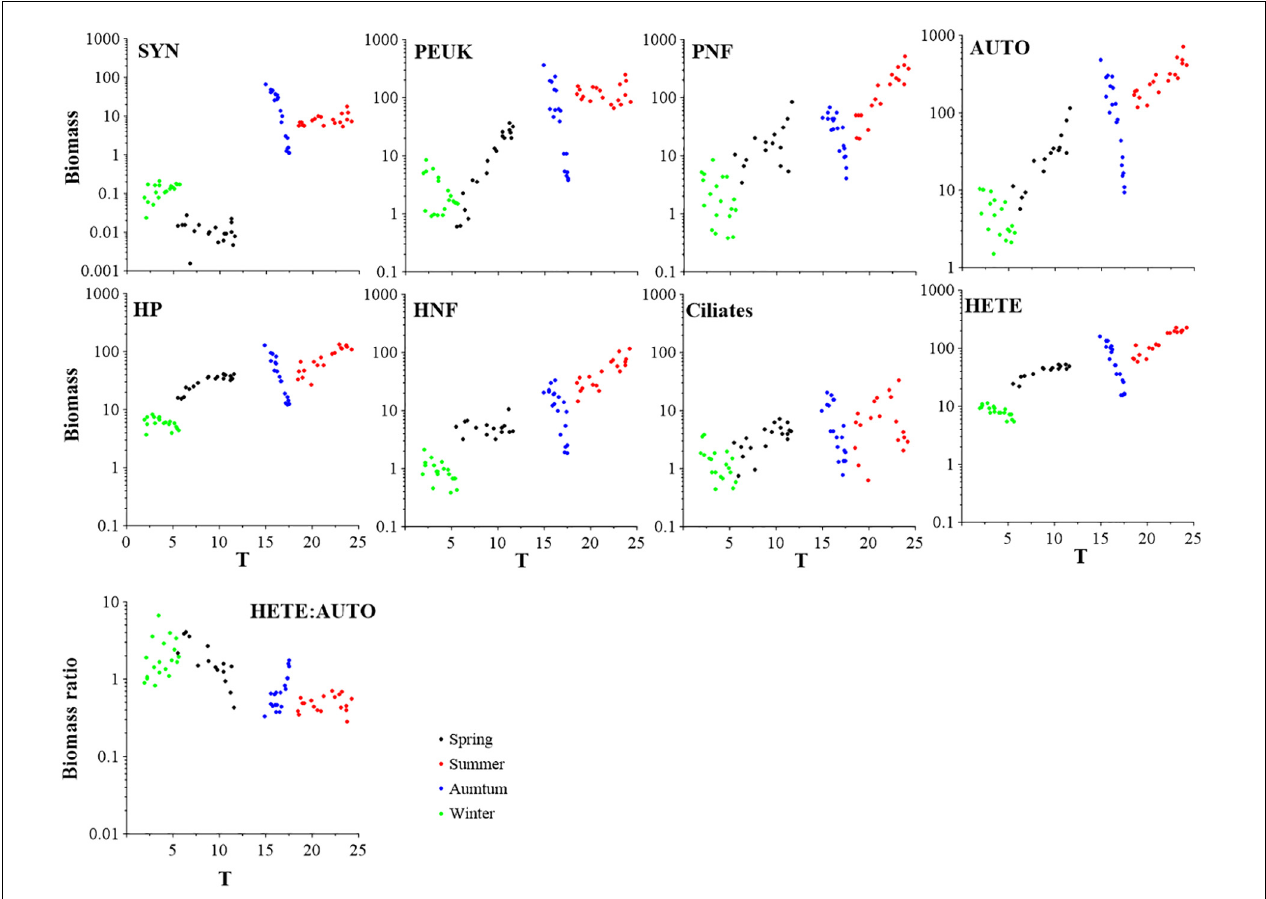
FIGURE 3 | Variations of different microbial food web component biomasses ( µ g C dm − 3 ) and biomass ratio of HETE to AUTO with respect to temperature increase. SYN, Synechococcus ; PEUK, phototrophic picoeukaryotes; PNF, pigmented nanoflagellates; HP, heterotrophic prokaryotes; HNF, heterotrophic nanoflagellates; AUTO, autotrophic organisms; HETE, heterotrophic organisms.